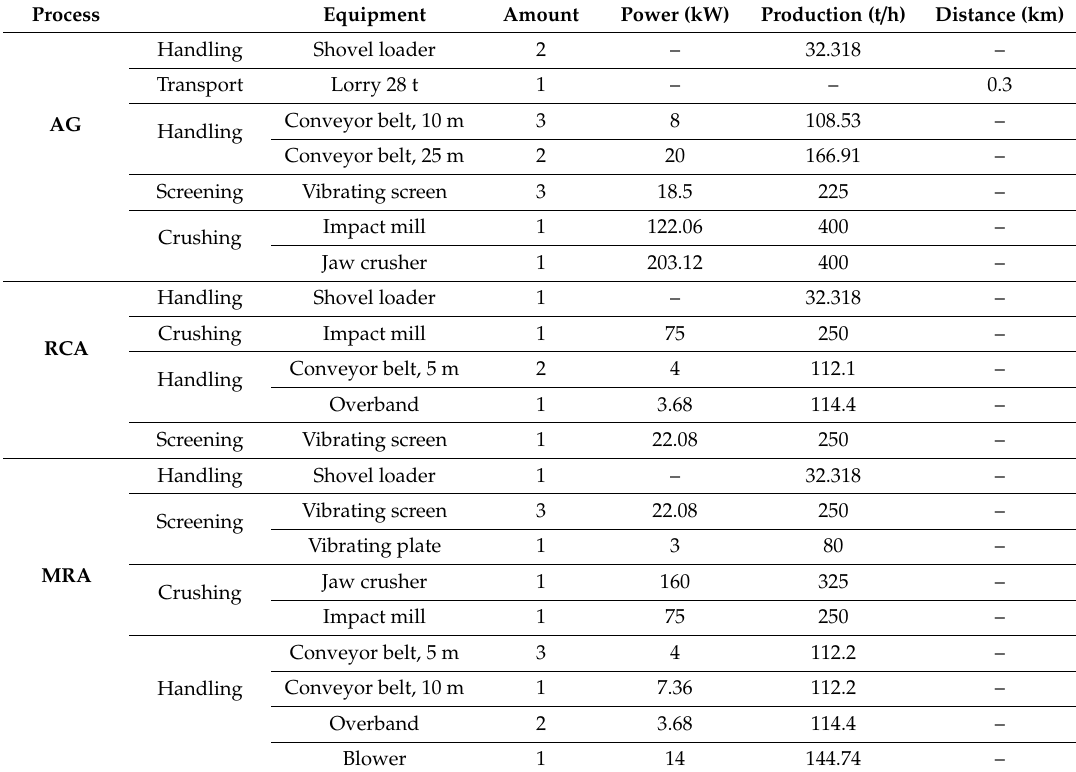
Table 10. Specifications of AG, RCA, and MRA production equipment